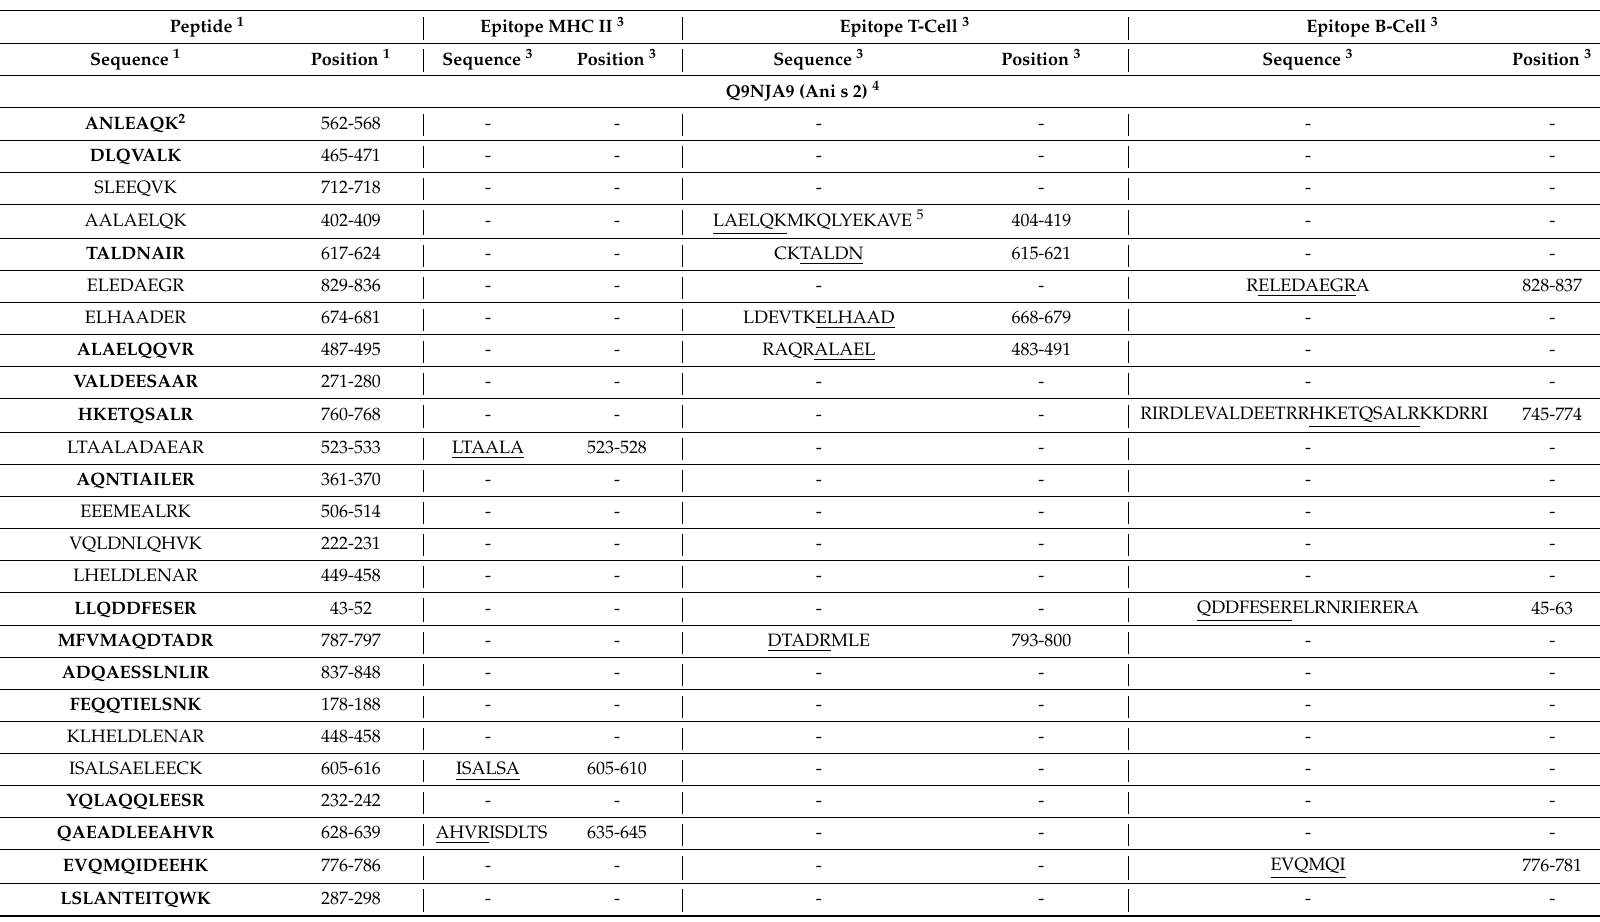
Table 5. List of in silico predicted epitopes (MHC II, T-cell, and B-cell) in Ani s 2, Ani s 3, and Ani s 4 peptides derived from the autoclaved antigen of A. simplex